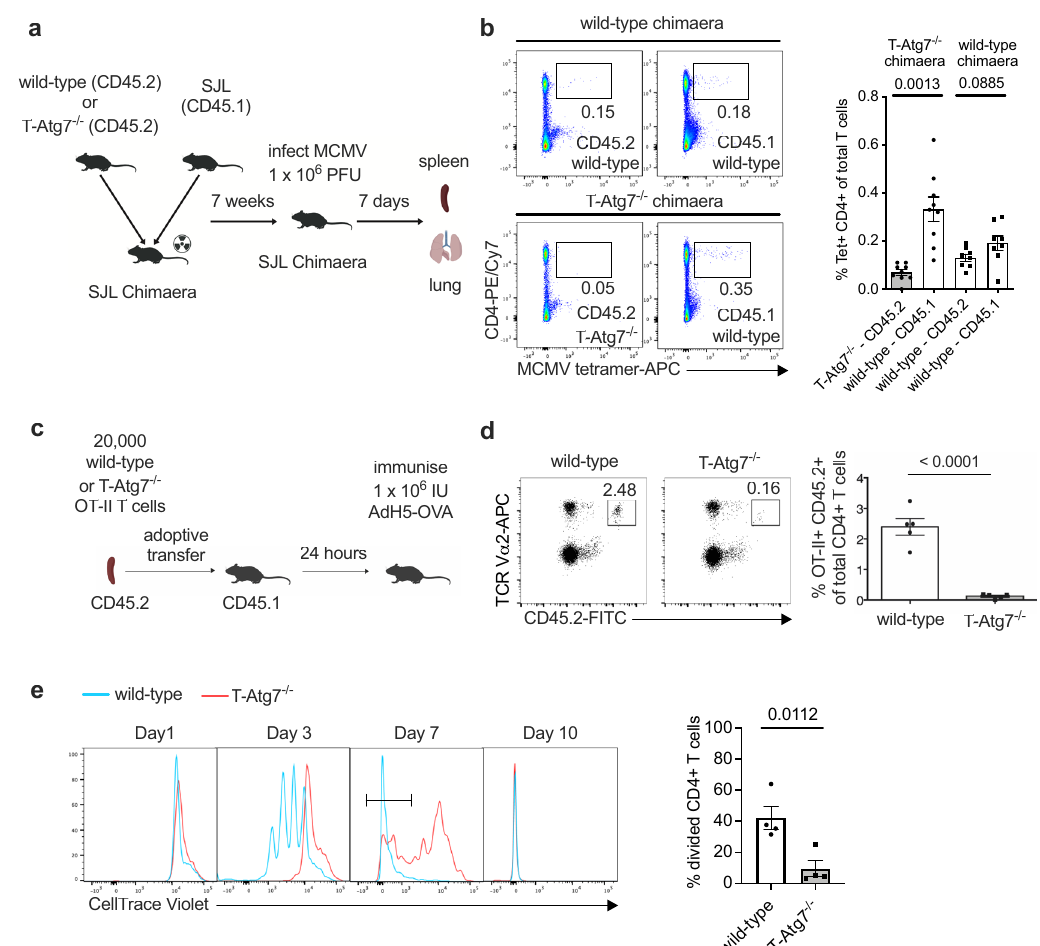
Fig. 1 | Autophagy-de fi cient CD4+T cells show delayed proliferation. a Experimental set-up for thegeneration of bone marrow(BM) chimaeras. Lethally irradiatedCD45.1+ hosts were reconstitutedwith a 1:1 mix of BMof either T-Atg7 − / − orwild-type(donorsbothCD45.2+)andCD45.1+wild-typeBM.After7weeks,hosts wereintravenously(i.v.)infectedwith1×10 6 PFUmurinecytomegalovirus(MCMV). Cells from spleens were collected and analysed 7 days post-infection. b Dot plots (left)ofsplenicMCMV-speci fi cCD4+TcellswithinCD19-populationfromCD45.2+ wild-type or T-Atg7 − / − donors and CD45.1+ donors. Bar graph (right) indicates percentage of tetramer (Tet)+ CD4+T cells within the CD45.2+CD19- or CD45.1+ CD19-population( n =8miceforwild-typechimaeragroup, n =9miceforT-Atg7 − / − chimaera group), represented as mean±SEM with paired two-tailed Student ’ s t test. c Experimental set-up for the adoptive transfer: OT-II lymphocytes (2×10 4 ) from either CD45.2 wild-type or T-Atg7 − / − mice were adoptively transferred into CD45.1 recipient mice. The recipient mice were orally immunised with 1×10 6 IU